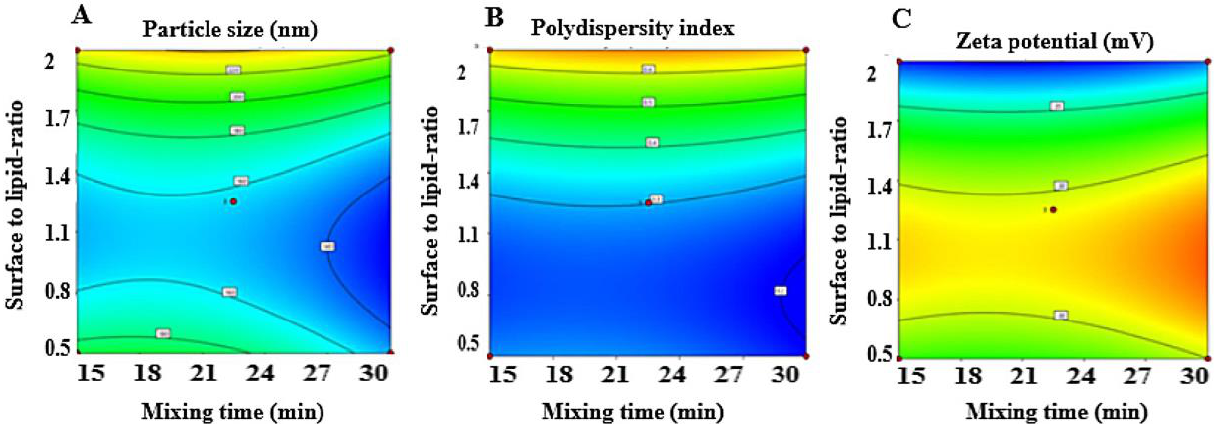
Figure 1. The contour plots of the effect of mixing time (X1) and surfactant to lipid ratio (X2) on particle size ( A ), polydispersity index ( B ), and Zeta potential ( C ) of tadalafil-loaded niosomes. (The red points are the design points).